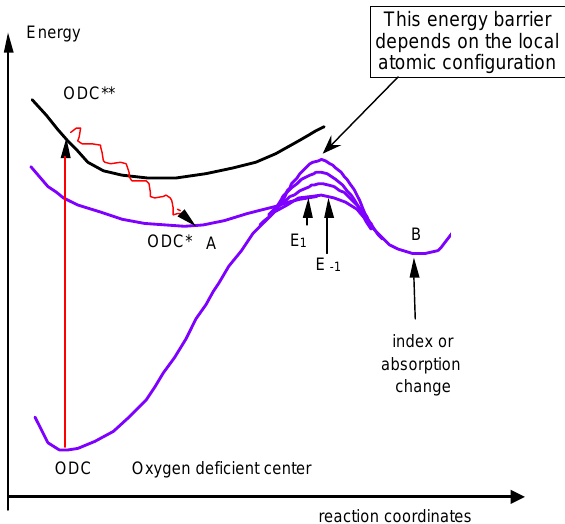
Figure 20. Example of the absorption step of a physical chemical reaction, followed by a thermally activated